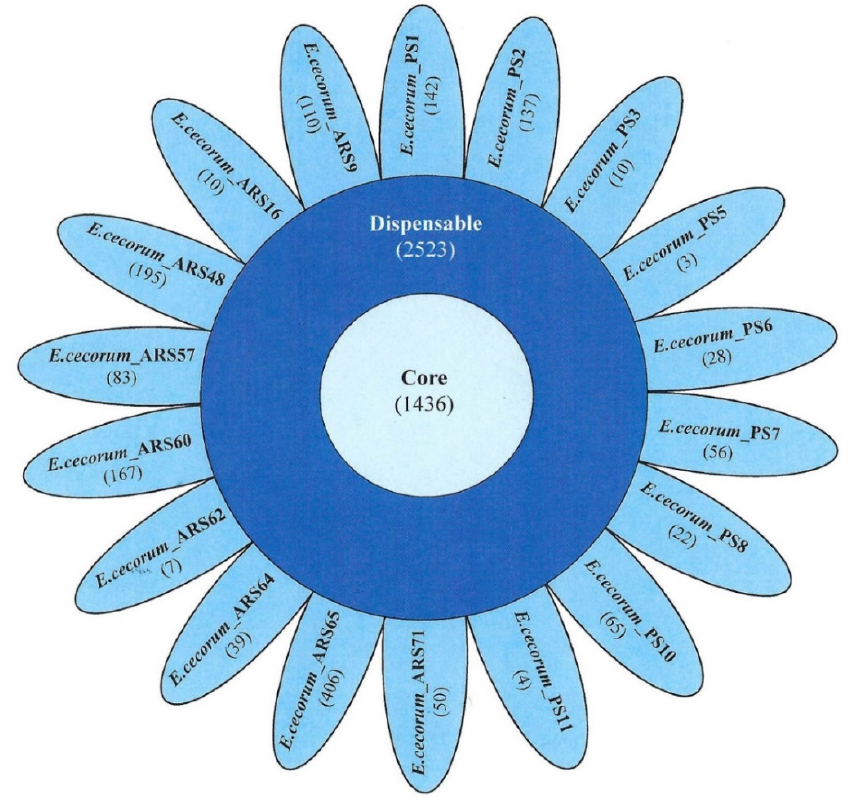
Figure 1. Venn diagram showing the pan-genome of 18 Enterococcus cecorum clinical (PS) and non-clinical (ARS) isolates from chicken. The number of core genes is the number of common genes shown in the center, while genes common between isolates are shown in the periphery (accessory genes). Each petal represents the unique genes in the respective isolates.